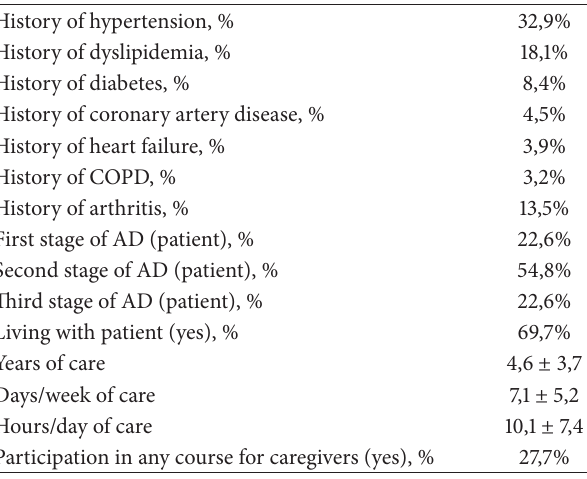
Table 2: Self-reported health status of the caregivers, living condi- tions, and time engaged in the care.